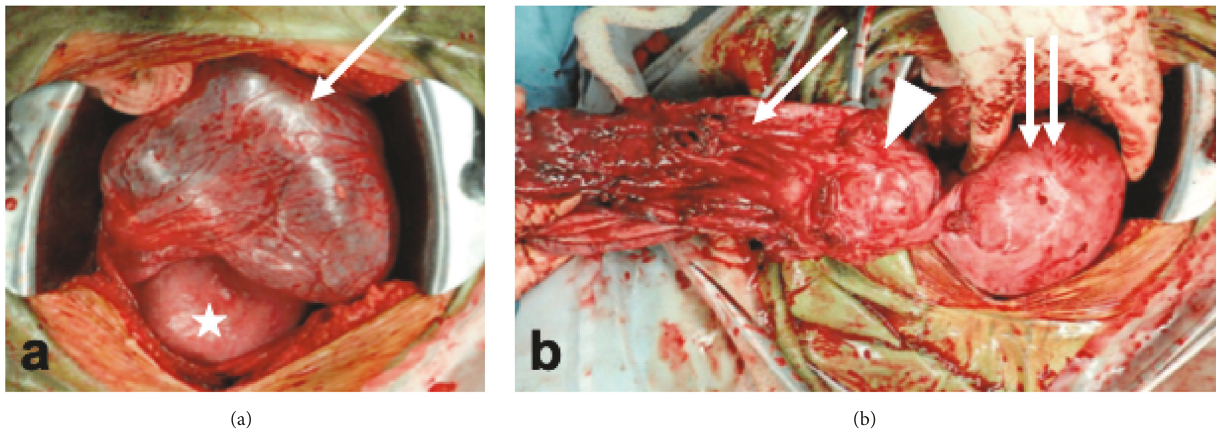
Figure 2: Intra-operative findings during cesarean section (CS) and tumor resection at 37 weeks of gestation. (a) The large cyst (arrow) is on the dorsal and caudal sides of the uterus (star) following CS. (b) The large cyst wall (arrow) is adjacent to the right multicystic ovarian tumor (arrowhead). We resected the right adnexa and a part of the cyst wall. The wall of the large cyst was coarse and weak, suggestive of degeneration. Uterus (double